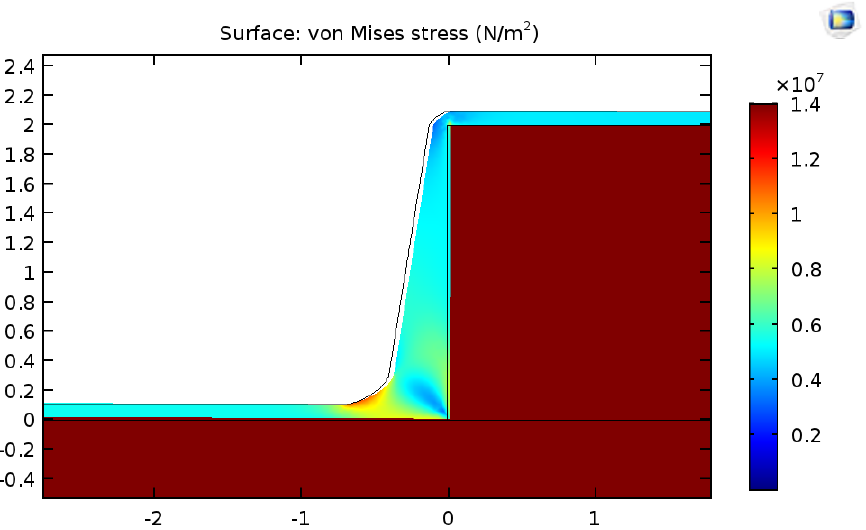
Figure 15. FEA modeling of conformal coating A stress distribution at −40 °C; x, y units are in mm. High local stress is observed near the junction between the chip and the PCB board, leading to a stress value twice greater than the constant tensile tress spatial distribution away from the chip. Similar stress distributions are observed for coating B, not shown